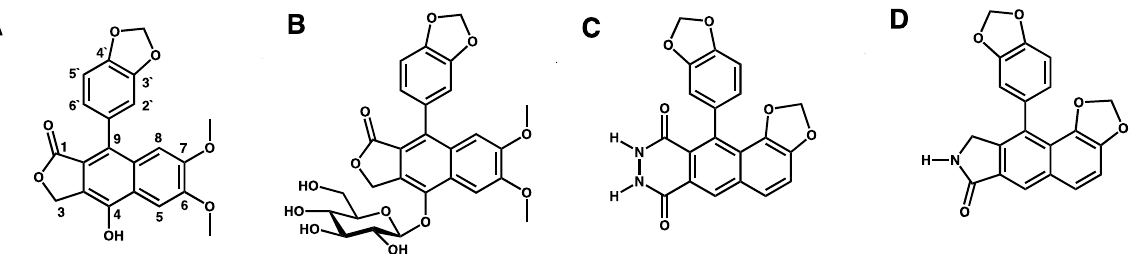
Figure 1. Structures of the studied compounds. ( A ) Diphyllin, ( B ) cleistanthin B, ( C ) helioxanthin 8-1, and ( D ) helioxanthin 5-4-2.